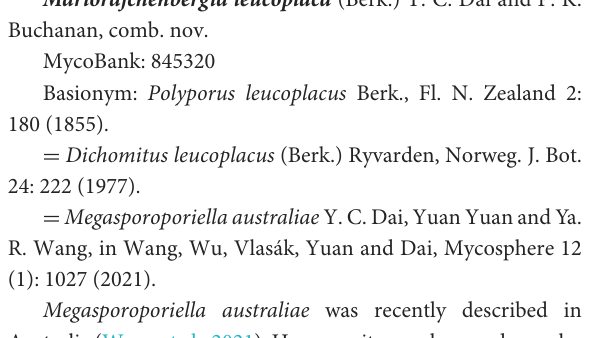
(Berkeley, 1872; Cunningham, 1965).